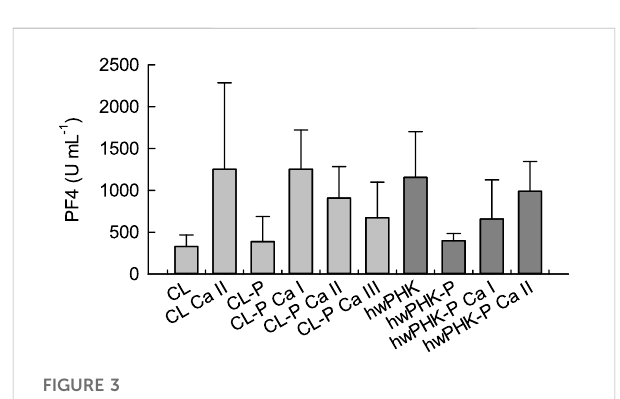
FIGURE 3 Platelet factor PF4 levels in whole human blood after 2 hours of incubation with the cellulose